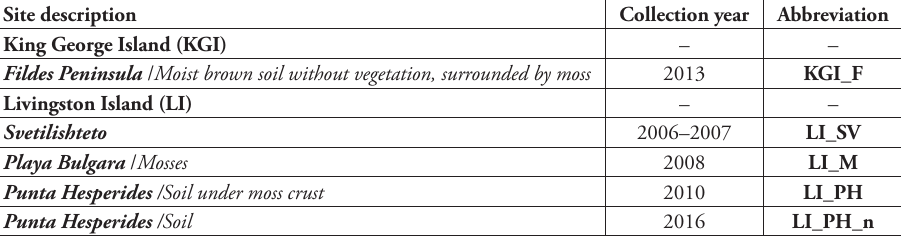
Table 1. Origin of the examined materials of Enchodeloides signyensis gen. n., comb. n.